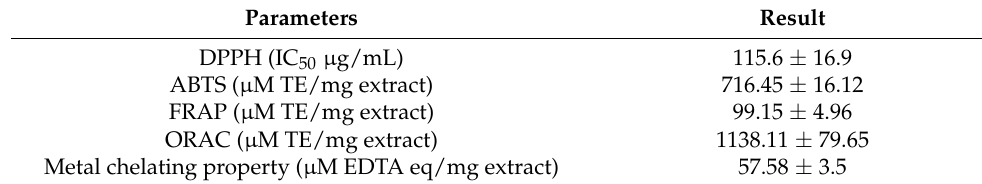
Table 5. Antioxidant capacities of the ERF of M. arboreus .